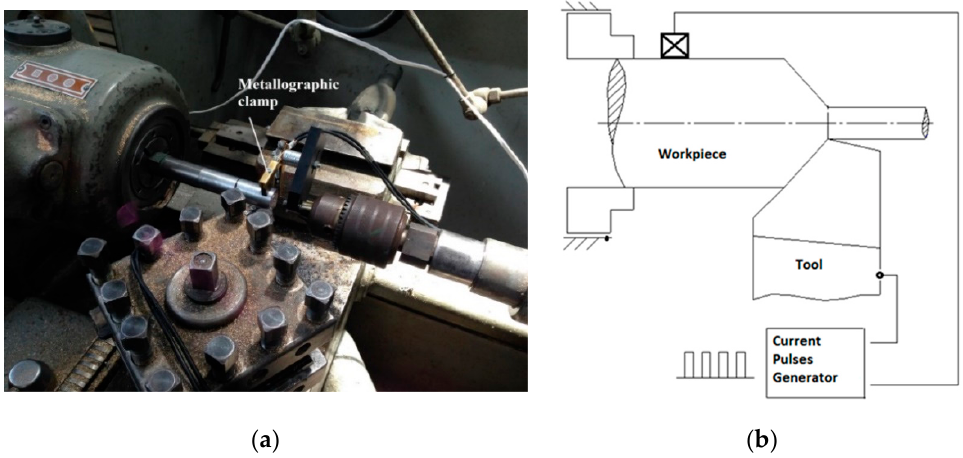
Figure 1. Electrical system and diagram to assist with electropulses. ( a ) Metallographic clamps used; ( b ) Electrical system to assist with electropulses.